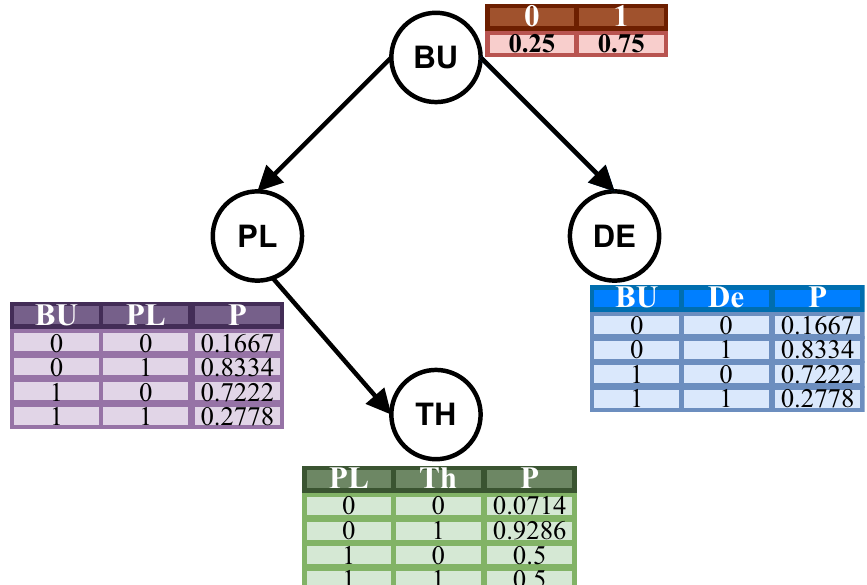
Fig. 9 Learned Bayesian Network Structure learning for the data available at Eq. (1), and its correlation information which helps in predictions and